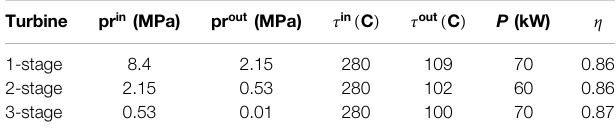
TABLE 3 | Rated parameters of the turbine. Turbine